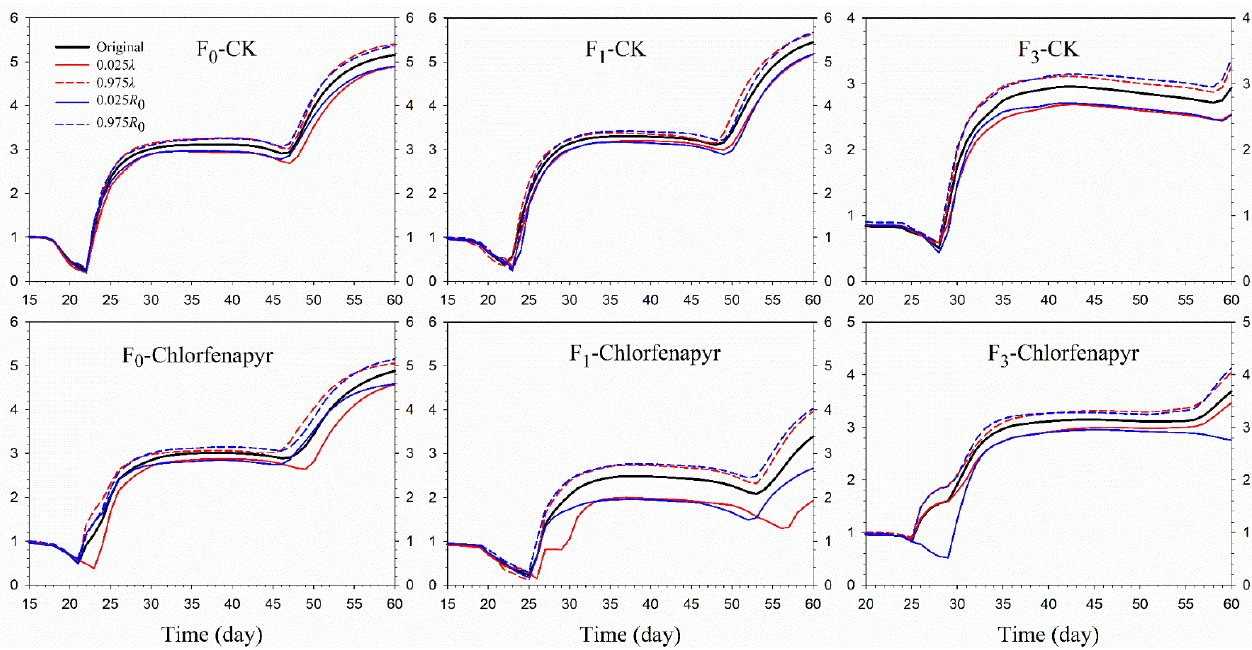
Figure 6. Population projection of P. marginatus (F 0 , F 1 , and F 3 ) exposed to LC 30 dose of chlorfenapyr by using the life tables based on the 2.5% and 97.5% percentiles of finite rate ( λ ) and net reproductive rate ( R 0 ). CK represents the control.